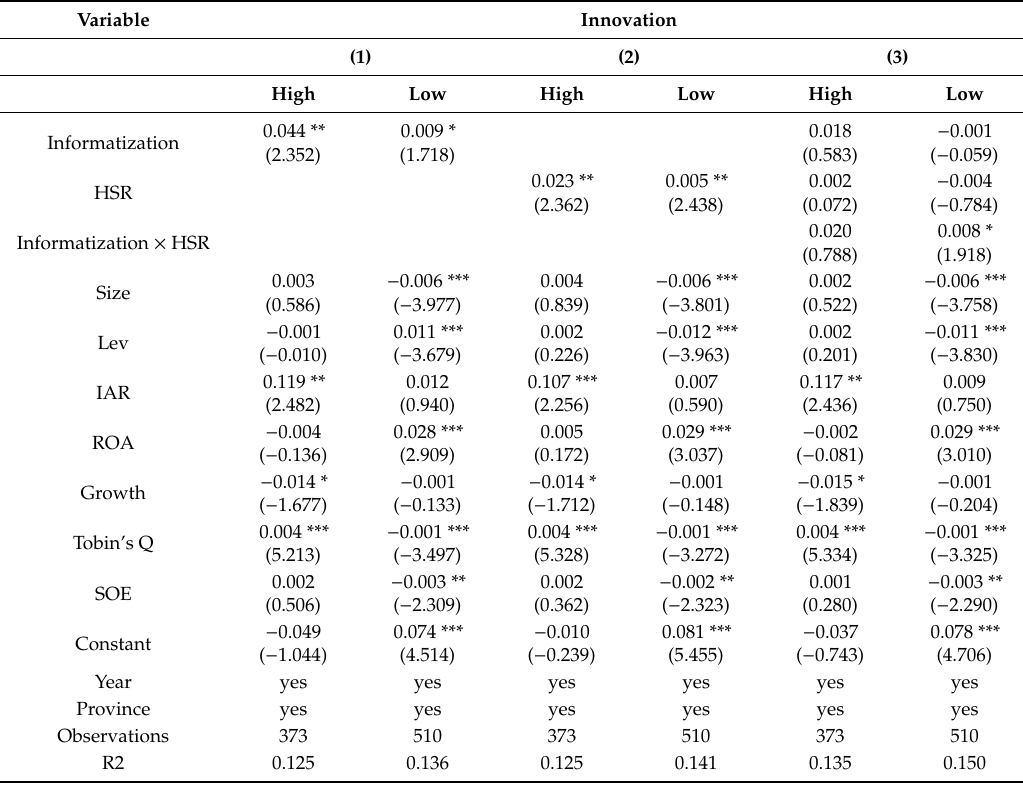
Table 4. Regression analysis